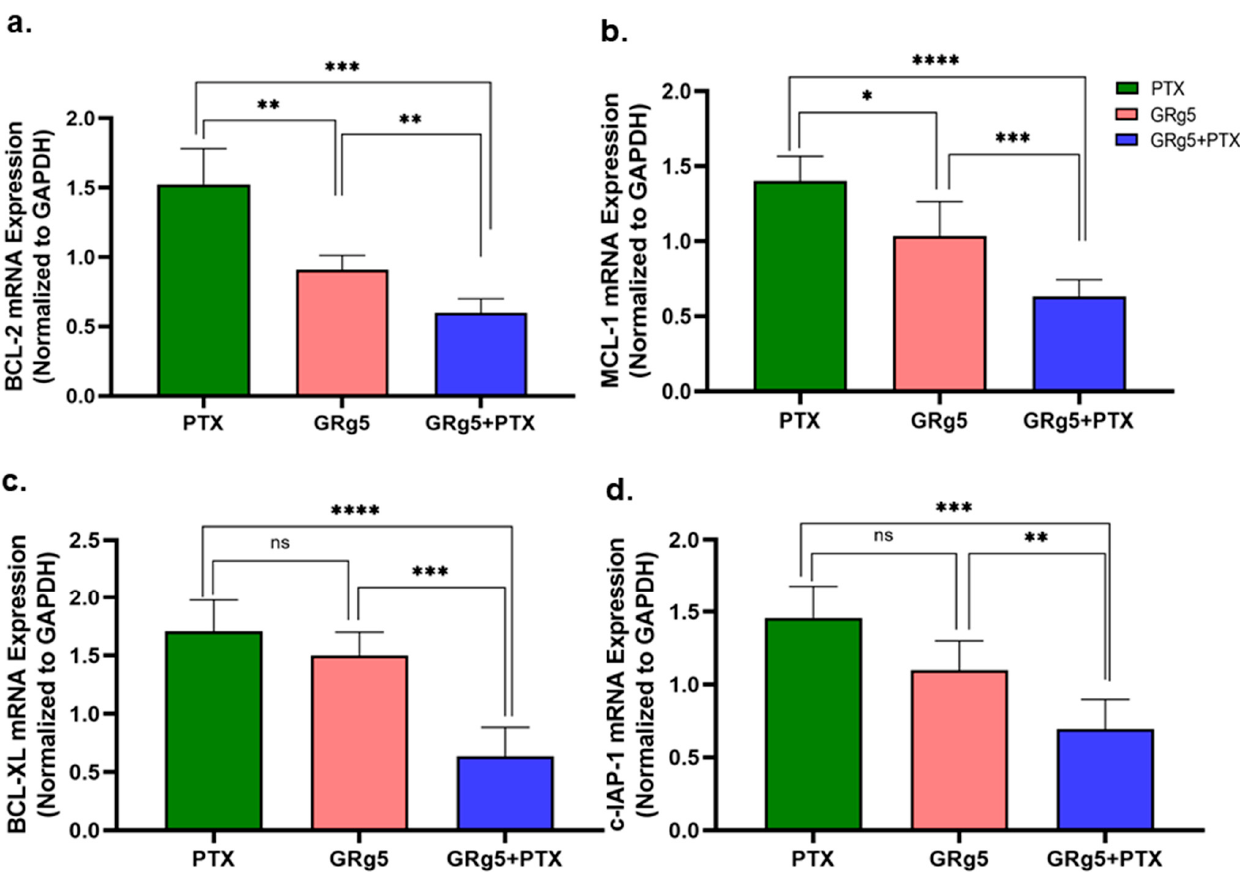
Figure 6. Quantitative RT-PCR analysis of anti-apoptotic regulatory genes: The mRNA expression of anti-apoptotic genes ( a ) Bcl-2, ( b ) MCL-1, ( c ) Bcl-xL, and ( d ) cIAP-1 in control and treated HeLa-PTX-R cells quantified relative to the control and normalized against the reference gene, GAPDH. Data is represented as mean ± S.E.M of three individual observations. Statistical significance was assessed using One way-ANOVA and Tukey’s post hoc test. ****, p < 0.0001; ***, p < 0.001; **, p < 0.01; *, p ≤ 0.05; ns, non-significant.